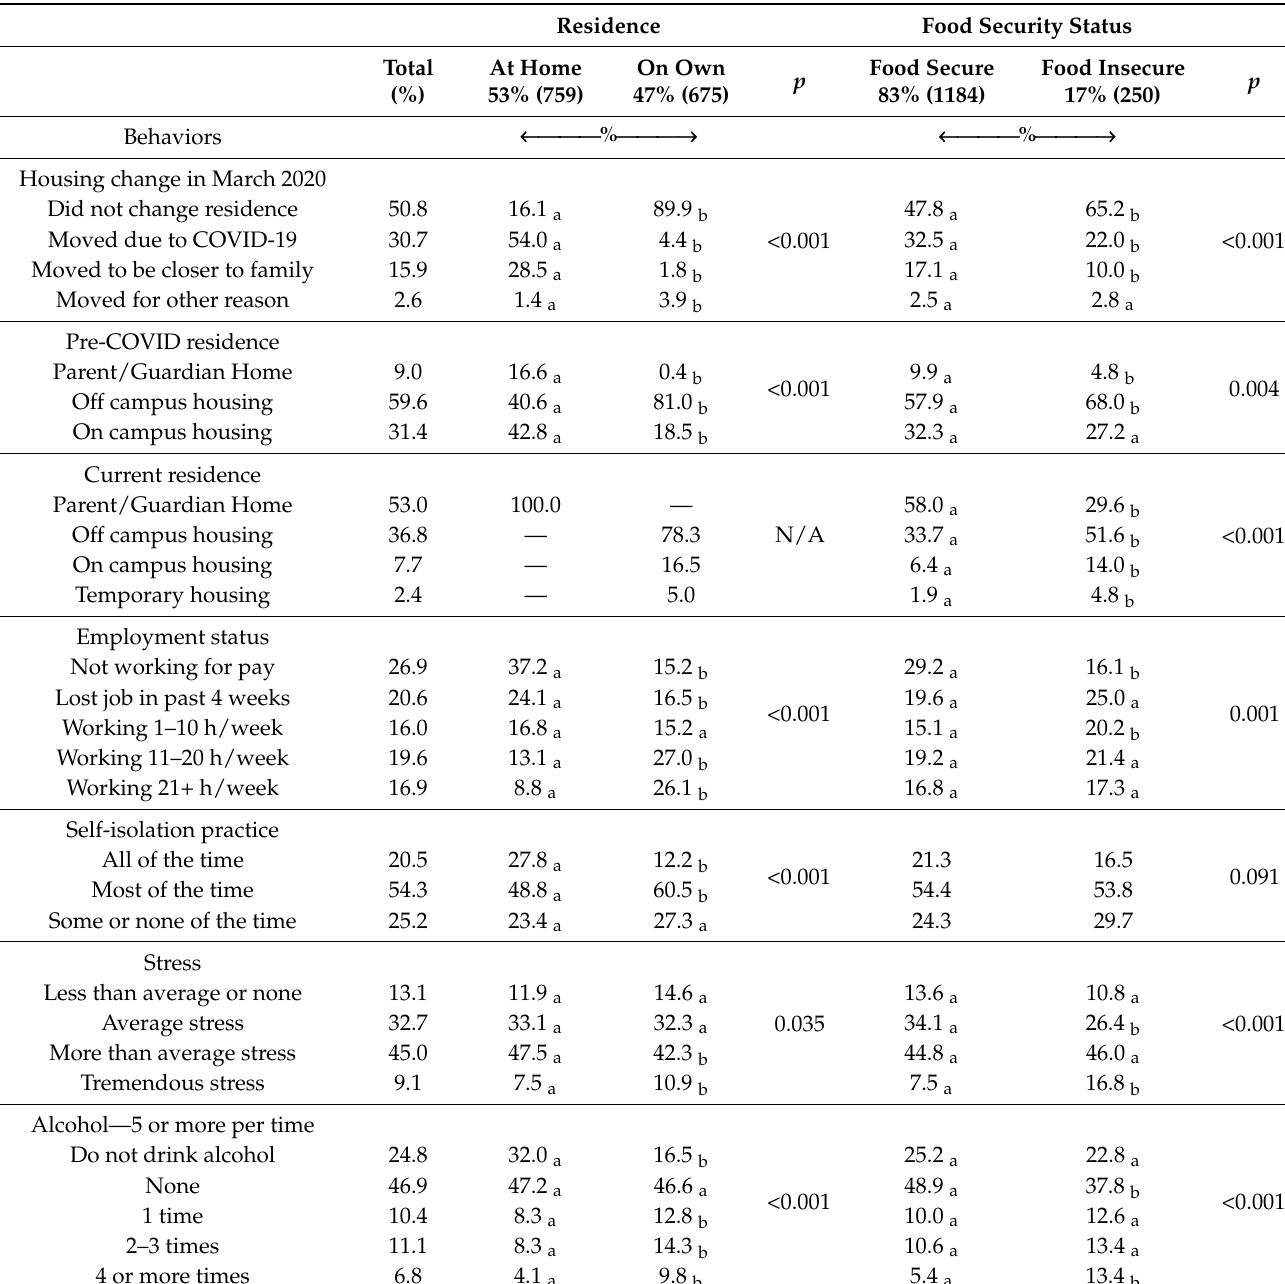
Table 1. Demographic characteristics of Midwestern university students by residence and food security status post- COVID-19 campus shift to online instruction (%; n = 1434).